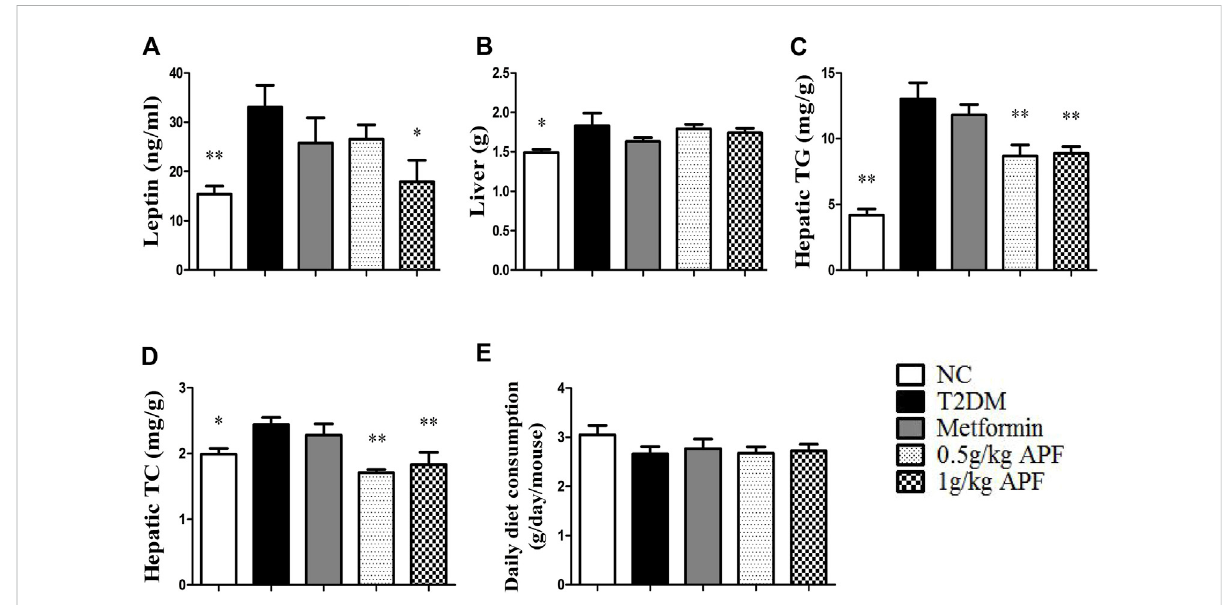
EffectsofAPFonhepaticsteatosisinT2DMmice.Plasmaleptin (A) ,liverweight (B) ,hepaticTG (C) ,hepaticTC (D) anddailydietconsumption (E) of normal control (white bars), type 2 diabetes group (black bars), metformin group (gray bars), 0.5 g/kg APF group (spot bars) and 1 g/kg APF group (grid bars) after treatment with APF 12 weeks. Values are means ± SEMs, n = 8 – 10 per group. * p < 0.05, ** p < 0.01 versus type 2 diabetes